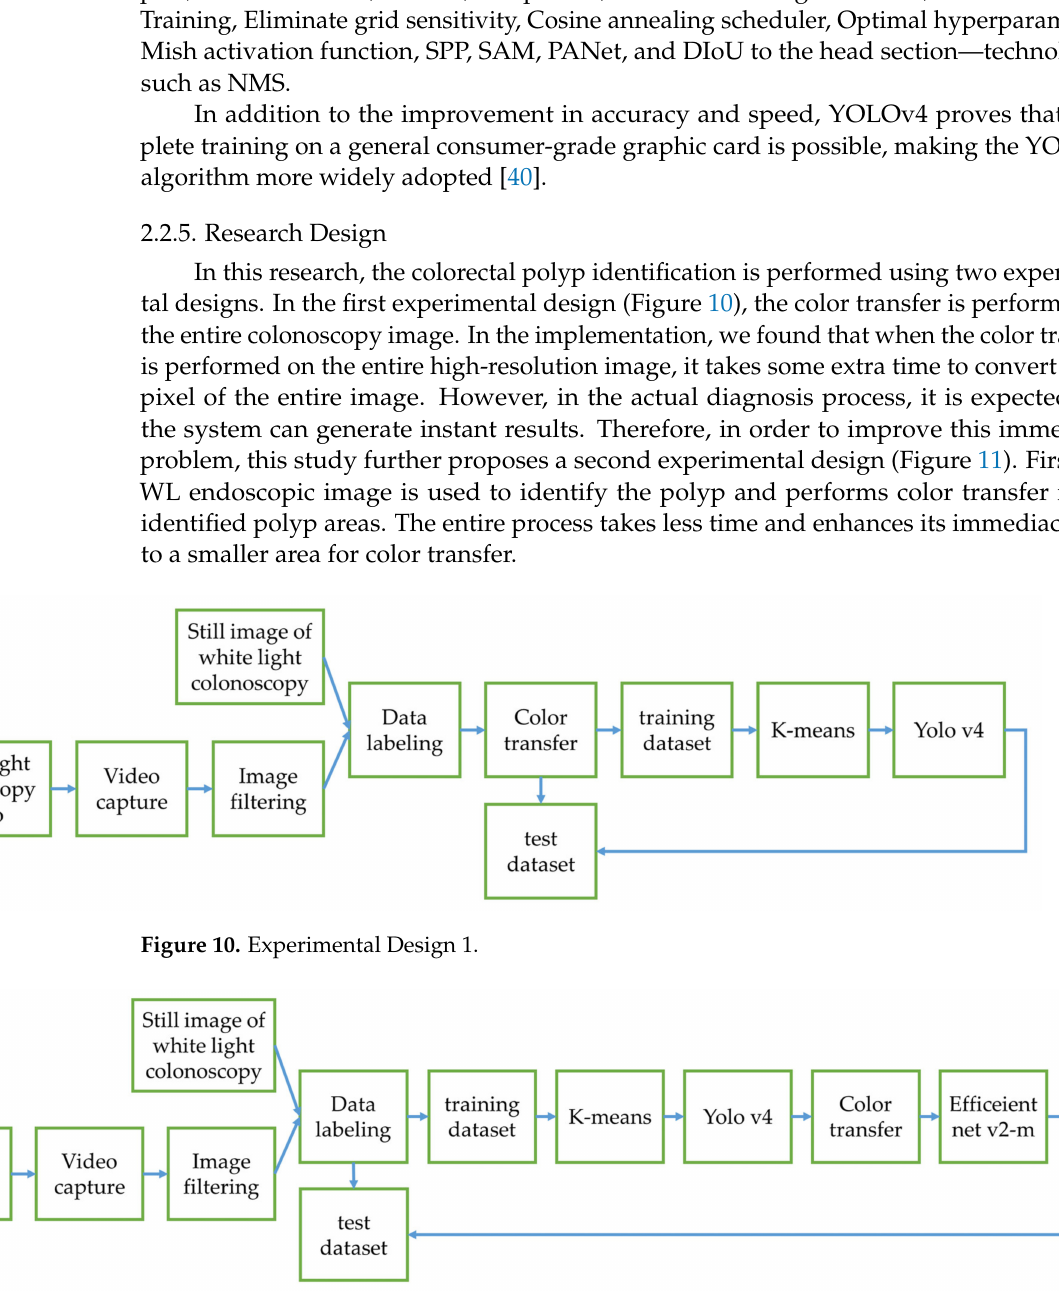
Figure 11. Experimental Design